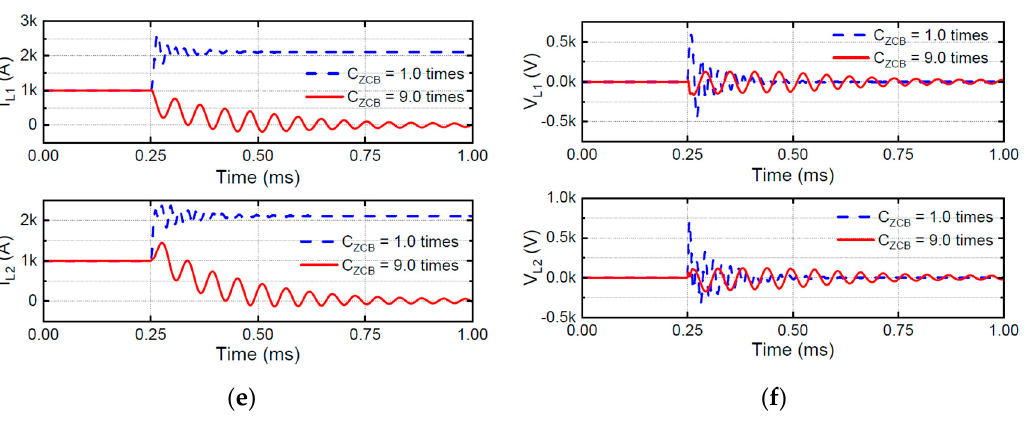
Figure 12. Simulation waveforms of featured components in the ZCB circuit. ( a ) Current and voltage of SCR. ( b ) Current and voltage of load. ( c ) Transient currents (i C0 + i C1 ) and (i C2 + i CL ). ( d ) Current and voltage of diode D 2 . ( e ) Current of inductor L 1 and L 2 . ( f ) Voltage across inductor L 1 and L 2 .